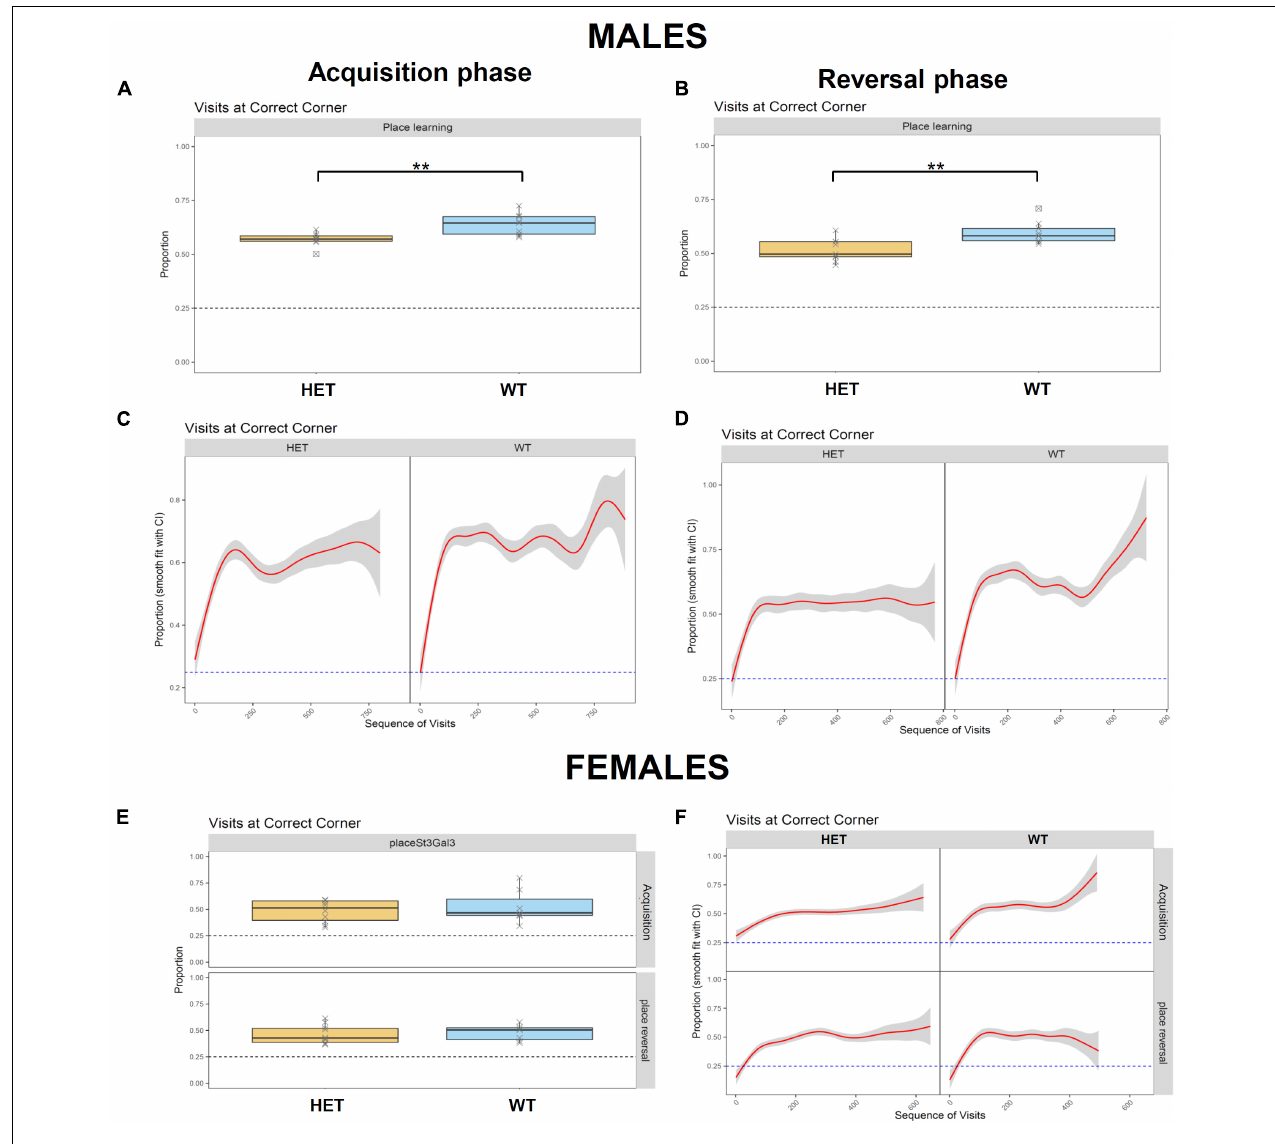
FIGURE 4 | Assessment of learning performance and cognitive flexibility in HET mice. Place learning module was divided in two phases, Acquisition and Reversal, where the percentage of correct responses (visits to the correct corner) was used to evaluate learning performance of the male ( n = 9/genotype) and the female ( n = 8 WT and 10 HET) cohorts. (A,B) HET male mice displayed a reduced proportion of correct responses compared their WT littermates in Acquisition (A) ( F 1 , 15 = 12.35, p = 0,003128) and Reversal (B) ( F 1 , 15 = 11.97, p = 0,003496). (C,D) Cumulative visits at the correct corner in Acquisition (C) and Reversal (D) . (E) Averaged proportion of correct responses by the female cohort in Acquisition and Reversal phases, where no genotype effects were observed. (F) Cumulative visits at the correct corner by the female cohort in Acquisition and Reversal. Data were analyzed and plotted with FlowR software. Data in panels (A,B,E) presented as mean ± SEM. Dotted line on each graph indicates random